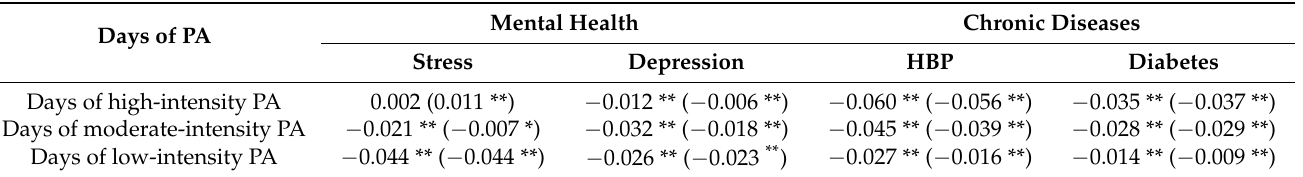
Table 6. Correlation analysis of the number of days of PA, mental health, obesity, and chronic diseases before and during